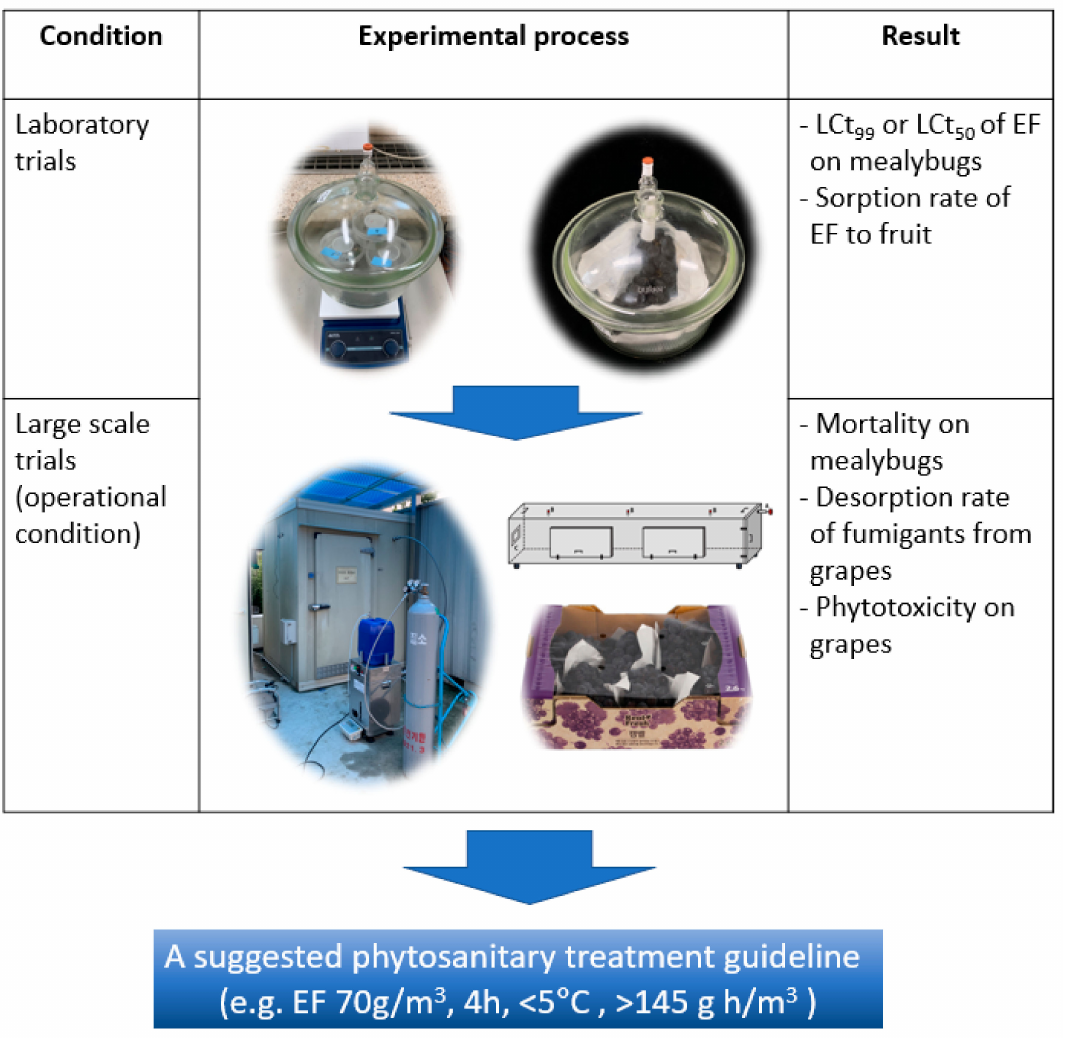
Figure 1. Illustrated methodology to develop a phytosanitary fumigation schedule and a suggested phytosantiry treatment guideline.